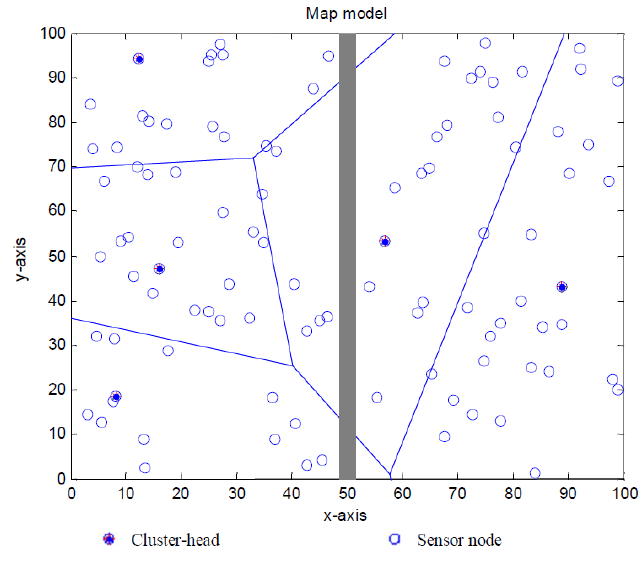
Figure 3. A non-uniform distributed WSN with a mobile sink moving on the centre